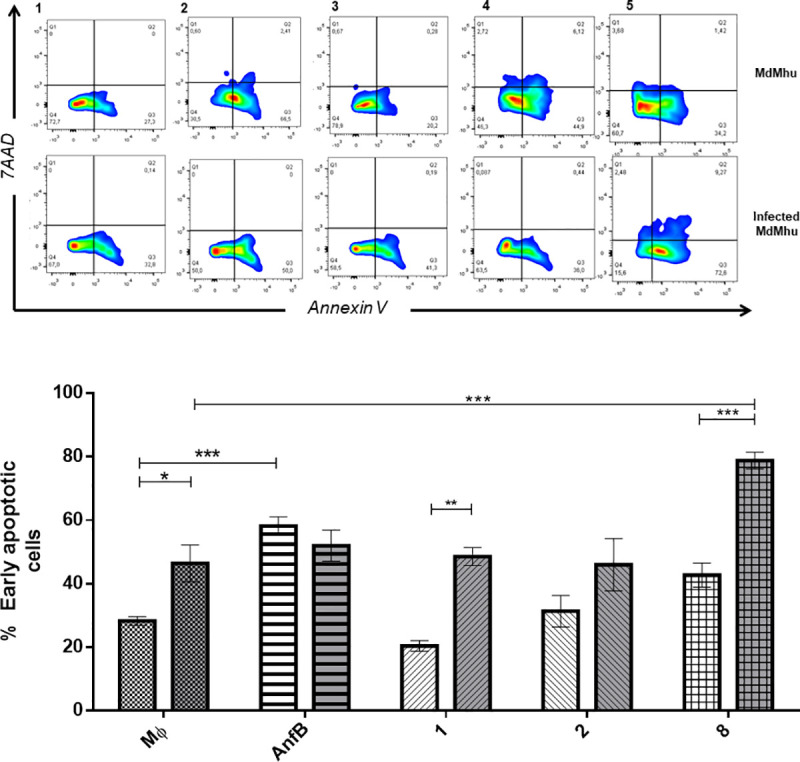
Percentage hMDMs during early apoptosis (annexin V+ 7AAD–). hMDMs treated with quinoline alkaloid–like compounds at EC50, evaluated by flow cytometry.(A) Dot plot of noninfected hMDMs: x axis, annexin V-PE; y axis, 7AAD. (1) M (uninfected or untreated hMDMs); (2) AmpB; (3) compound 1; (4) compound 2; (5) compound 8. (B) Bar plot of the percentage of events (cells) for (a) noninfected hMDMs and (b) Leishmania (Viannia) panamensis-infected hMDMs (IMs) treated with compounds 1, 2, and 8. *p < 0.05; **p < 0.01; ***p < 0.005. EC50, medial effective concentration; hMDMs, human monocyte-derived macrophages.